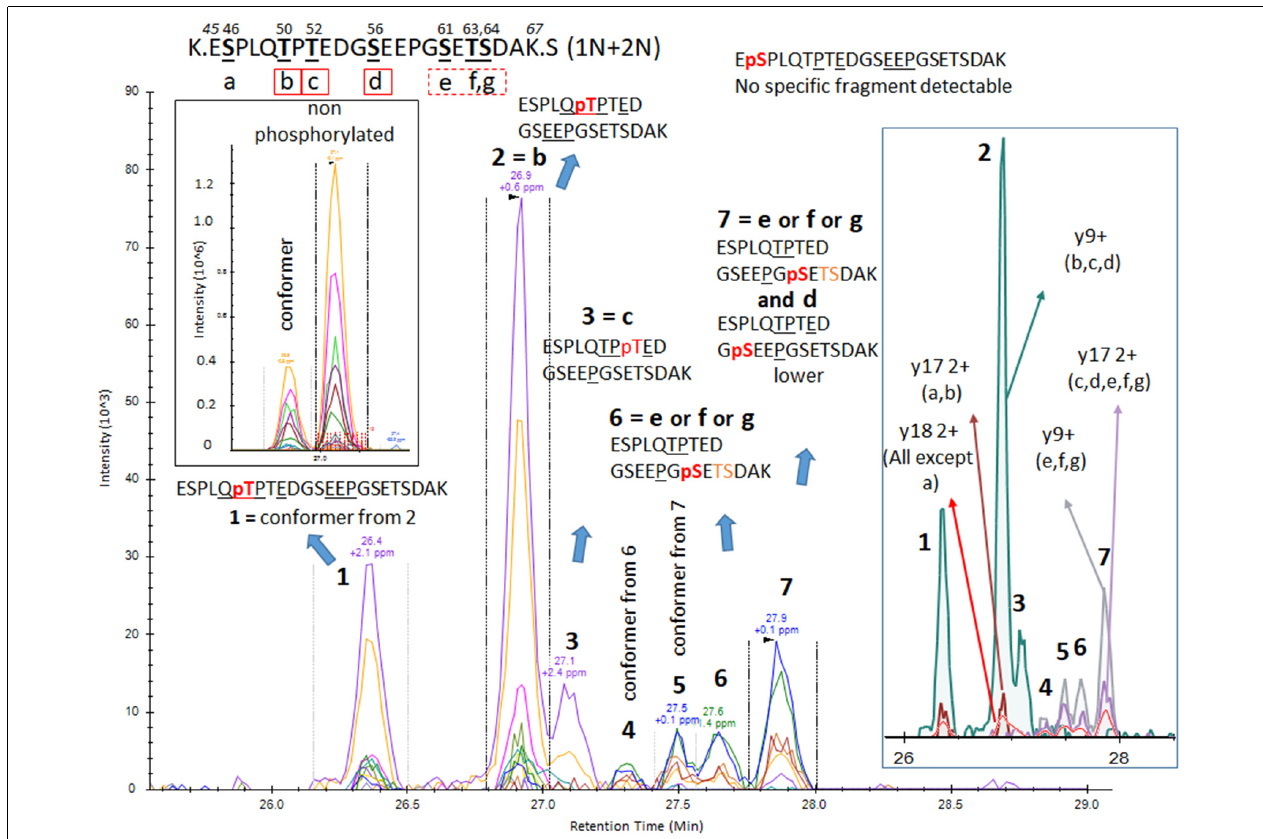
FIGURE 4 | PRM screening of mono-p-tau sequence 45–67 (1N and 2N isoforms). A strong signal from a conformer was identified on the front of a non-phosphorylated peptide LC-MS pattern. Thus, we predicted that corresponding LC-MS patterns for phosphorylated peptides would also have conformers separable by LC. Indeed, PRM scan interpretation led to the detection of pT50 (b) as the main phosphorylation site on this sequence (pattern 2). Pattern 1, with a similar fragmentation fingerprint, was attributed to a conformer of pT50. pS46 (a), able to differentiate signals from pT50 (b), was not detected, suggesting this phosphorylation would be absent or low and co-eluted with other phosphorylated peptides sharing similar non-specific fragments. Co-elution of y9, y15 without phosphate, and y17 with phosphate in LC-MS pattern 3 identified a phosphorylation on residue T52 (c). Patterns 4/6 and 5/7 were respectively paired as conformers. Thus, two phosphorylated peptides could not be separated. Fragments found in these patterns were consistent with phosphorylation on one of the S61 (e), T63 (f), and S64 (g) residues. MS/MS intensities were insufficient to identify the sites but at least two of these three sites were likely phosphorylated on this sequence. Additionally, a minor y9 fragment without phosphate was found in the shoulder of pattern 7, which could be attributed to minor phosphorylation on residue S56